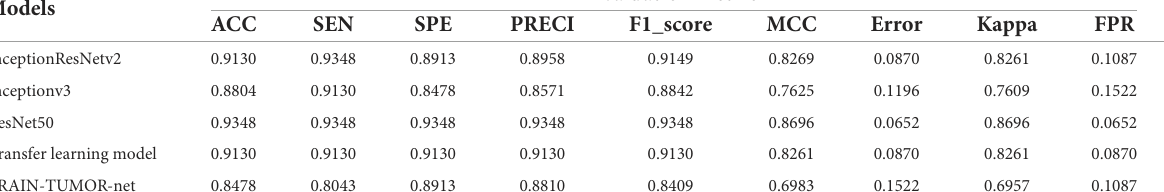
TABLE 1 Detection performance results for various CNN models with a 75/25 training/testing ratio on the first dataset. Models